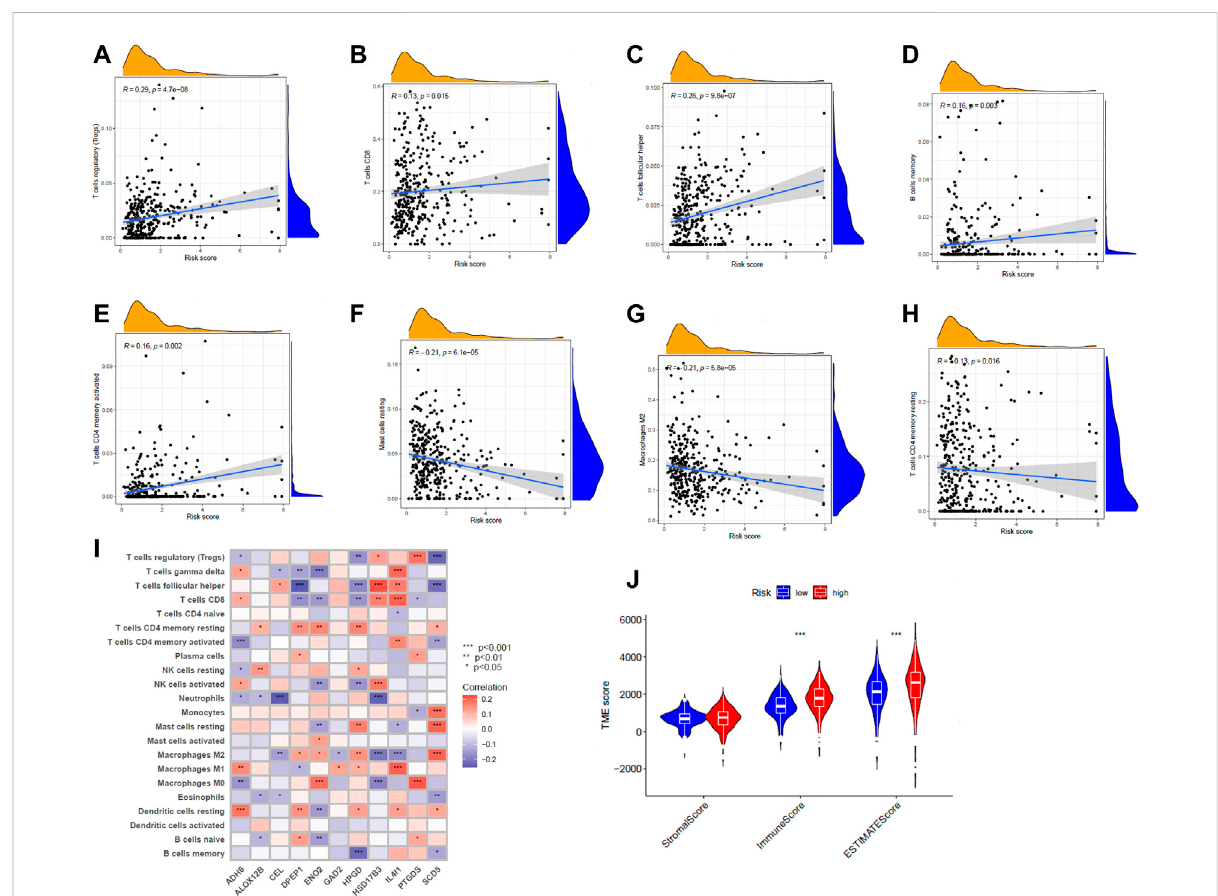
FIGURE 6 (A – H) Correlation between risk scores and various immune cells. (I) Correlation of 11 genes and immune cell content. Red means positive association, and purple means negative association. The shade of the color indicates the strength of the correlation. (J) Violin plot indicating differences in tumor microenvironment scoring for different risk